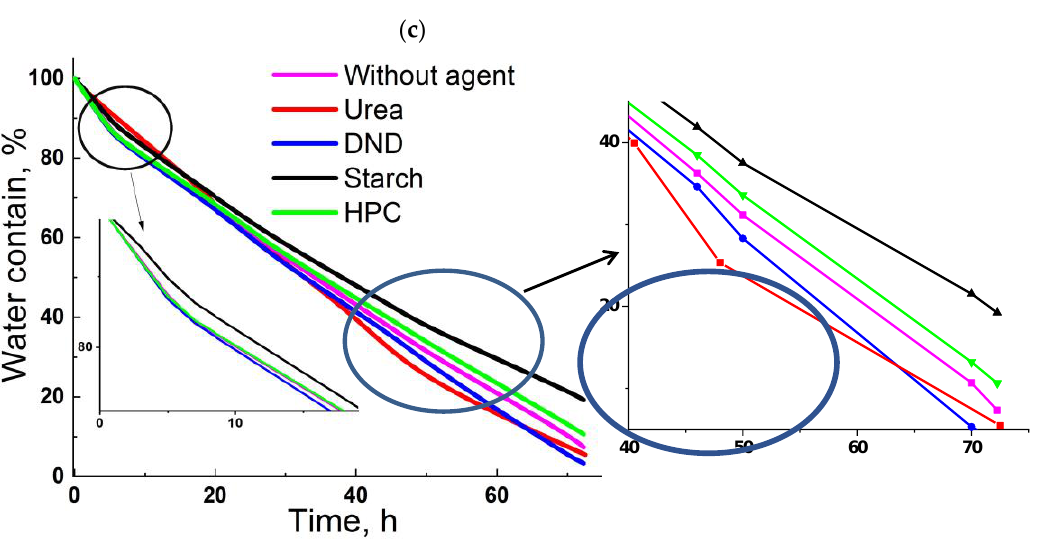
Figure 6. Dependences of the swelling degree of cryogels vs. content of additional agents ( a ); sorption properties of cryogels (obtained in the presence of 3 wt% of additional agents) in various solutions ( b ); water retention of cryogels ( c ).